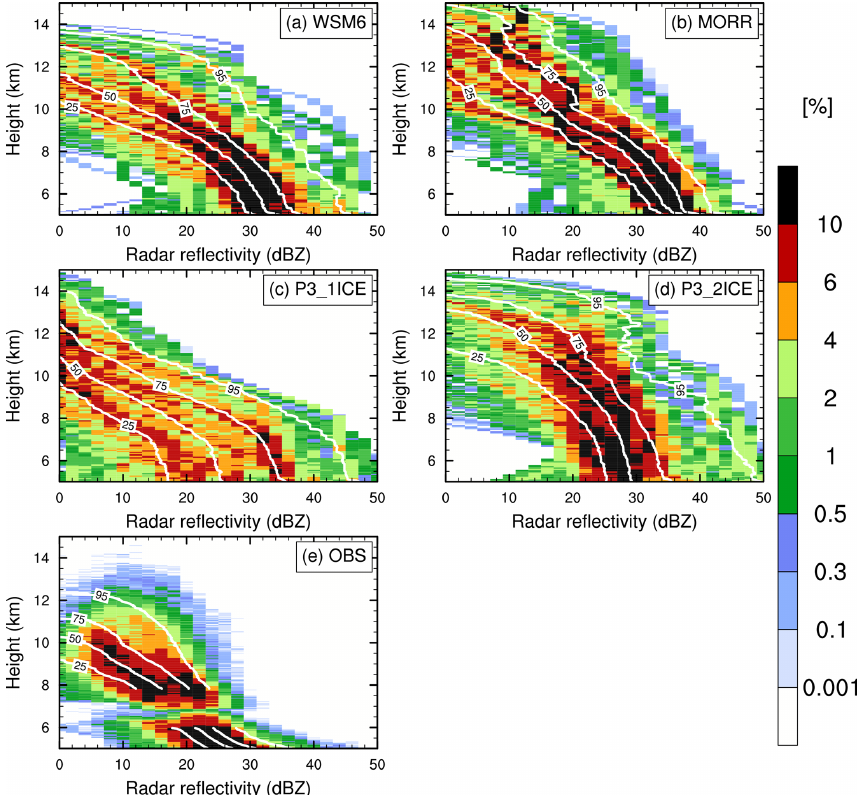
Figure 7. Frequency (%, shaded) of simulated ( a : WSM6, b : MORR, c : P3-1ICE, d : P3-2ICE) and observed (e) X-band radar reflectivity. Contours represent cumulative frequencies 25%, 50%, 75%, and 95%, respectively. The gap at 6–7km in (e) is due to observed radar reflectivity data not available at the first few range gates (within ∼ 500m) from the